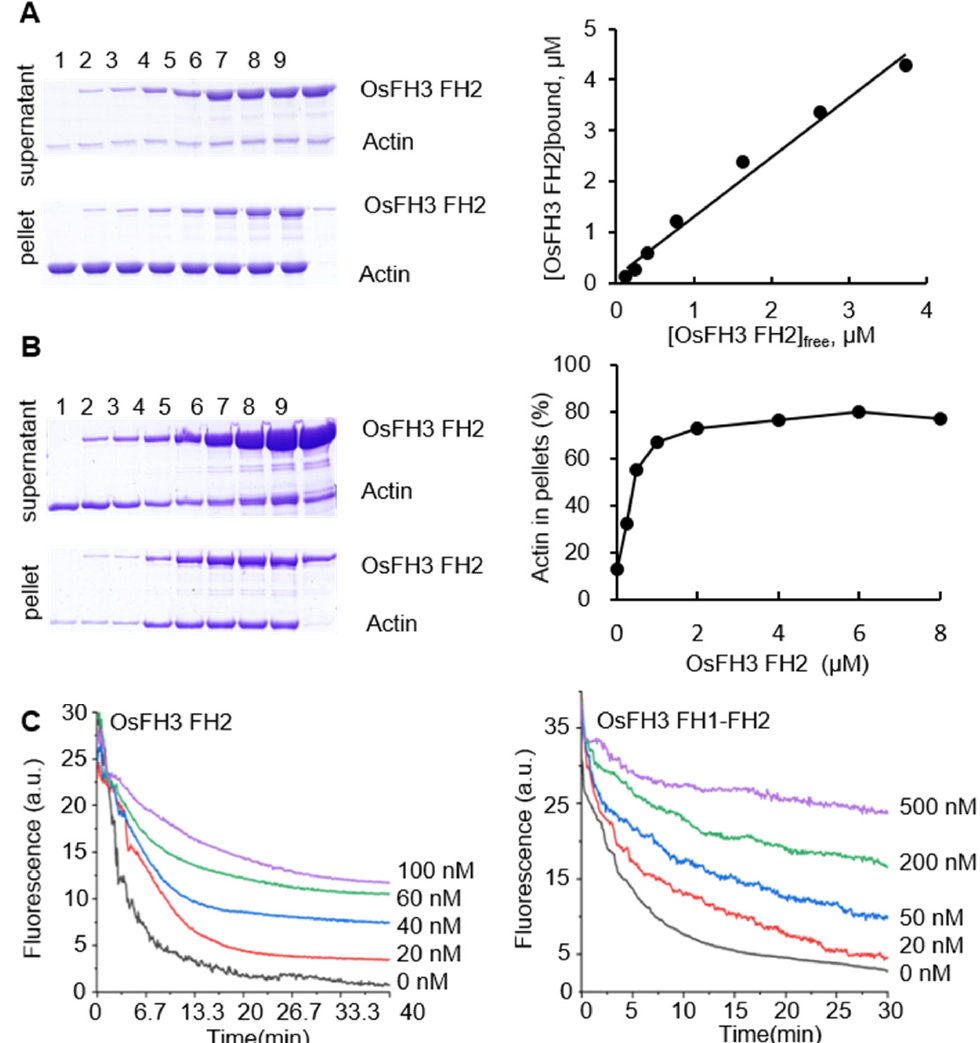
Figure 5. OsFH3 FH2 domain bundles and caps AF. ( A ) Determination of AF binding to OsFH3 FH2 using high-speed co-sedimentation assays. Lanes 1–8, 5 µ M actin with 0, 0.25, 0.5, 1, 2, 4, 6, and 8 µ M OsFH3 FH2, respectively; lane 9, 8 µ M OsFH3 FH2, no actin. Graph ( left ) shows quantification of Coomassie staining on protein gel ( right ). ( B ) Determination of AF binding to OsFH3 FH2 using low-speed co-sedimentation assays. Lanes 1–8, 5 µ M actin with 0, 0.25, 0.5, 1, 2, 4, 6, and 8 µ M OsFH3 FH2, respectively; lane 9, 8 µ M OsFH3 FH2, no actin. Graph ( left ) shows quantification of Coomassie staining on protein gel ( right ). ( C ) Kinetics of AF depolymerization in the presence of OsFH3 FH2 ( left ) or OsFH3 FH1–FH2 ( right ). Pyrene fluorescence (a.u., arbitrary units) is proportional to actin polymer